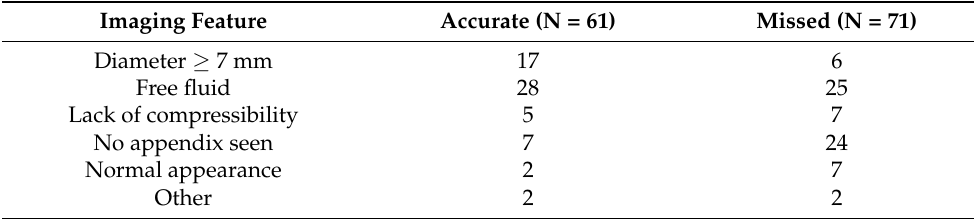
Table 3. Ultrasound findings for appendicitis diagnoses.